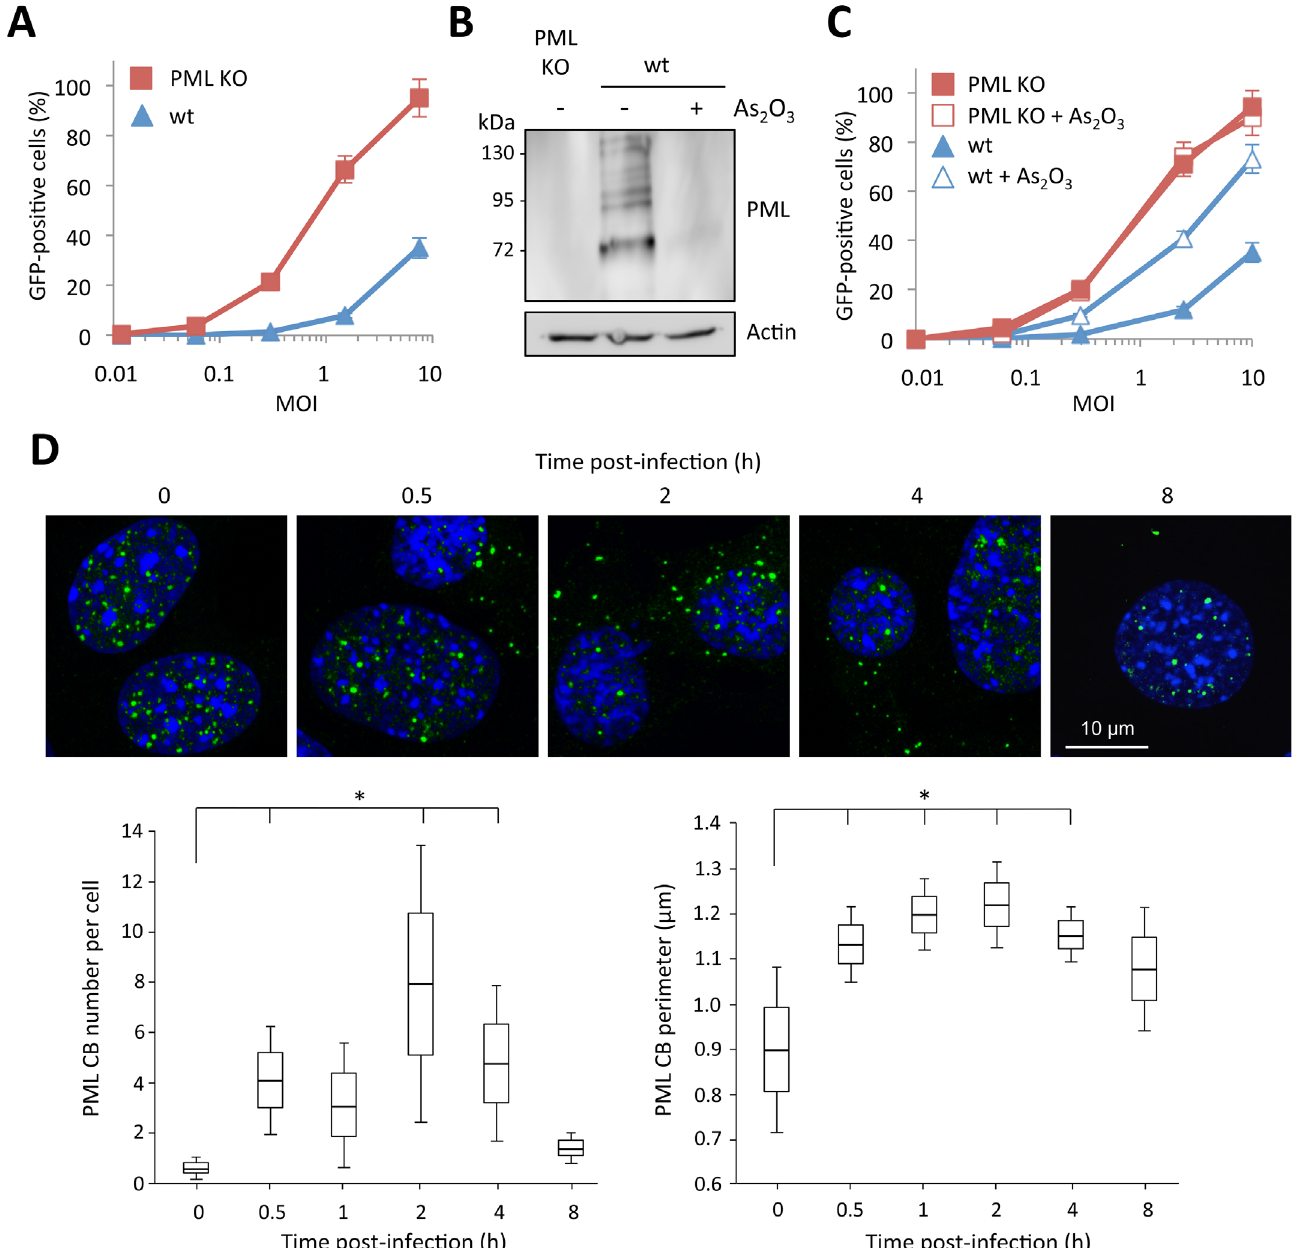
Fig 2. Role of murine PML in HIV-1 transduction. (A) Wt or PML KO MEFs were transduced at different MOI with HIV-1 derived lentivector expressing GFP during 48h and the percentage of GFP expressing cells was determined by flow cytometry. The graph shows means of duplicate values +/- SD, representative of three independent experiments. (B and C) Wt or PML KO MEFs were treated with 2.5 μ M of As 2 O 3 during 24h, PML degradation was evaluated by western-blot (B) and cells were infected at different MOI with HIV-1 vector during 48h and the percentage of GFP expressing cells was determined by flow cytometry (C). The graph shows means of duplicate values +/- SD, representative of three independent experiments. (D) Wt MEFs were infected for different times at MOI 10 with HIV-1 derived vector and PML localization was determined by immunofluorescence. For each time-point, the number and perimeter of PML CBs was quantified in 50 cells from 5 independent fields. Student t-test was performed to determine P values. ( * P <